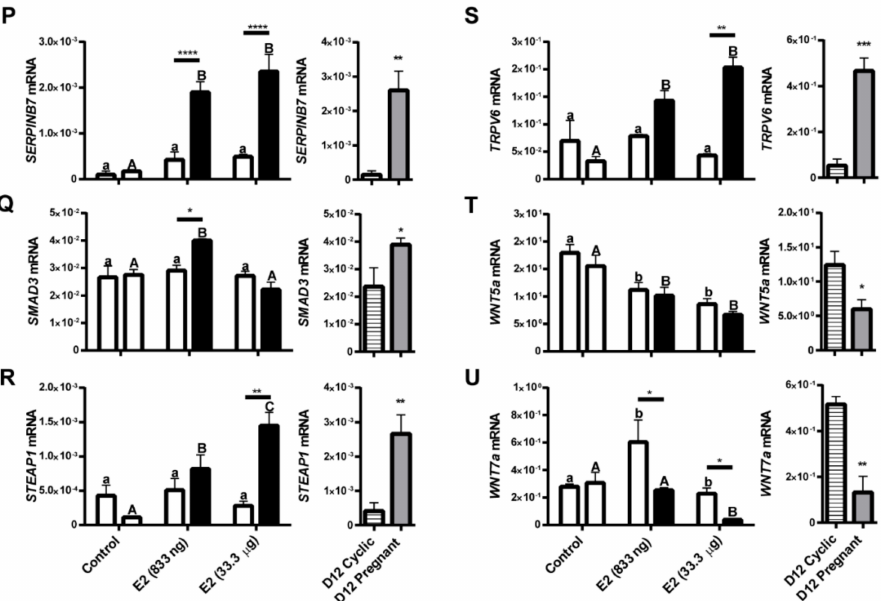
Figure 6. Expression of selected target genes determined by real-time RT-PCR in porcine endometrial samples treated with a placebo (control) or E2 (833 ng and 33.333.3 µ g / infusion) and on day 12 of the estrous cycle (D12 Cyclic) and pregnancy (D12 Pregnant). Data are presented as the mean ±